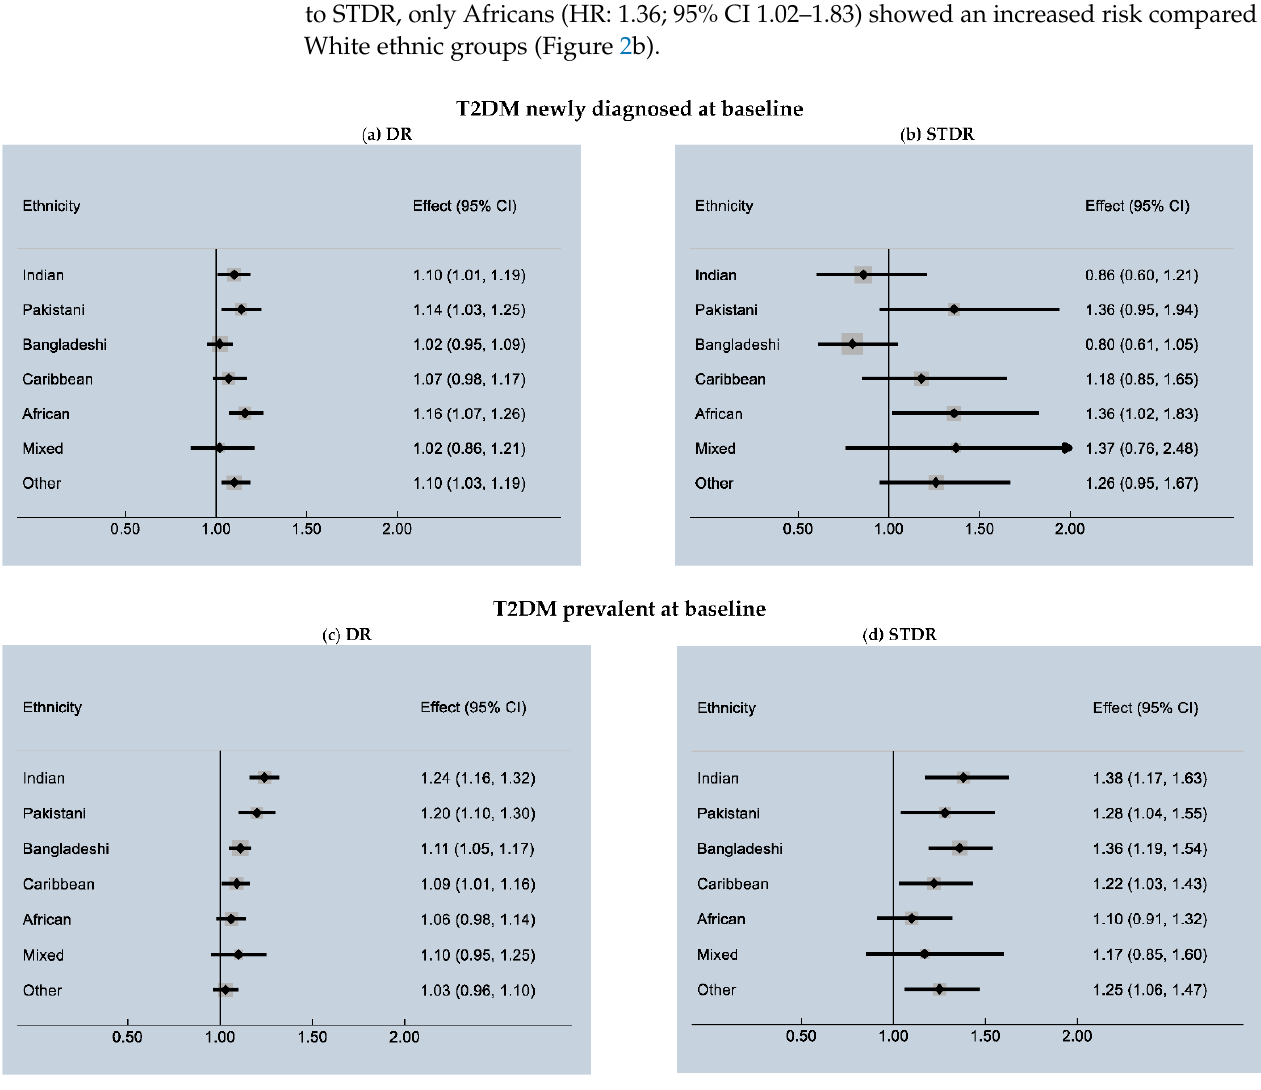
Figure 2. Risk of DR and STDR in ethnic minorities compared to white population.